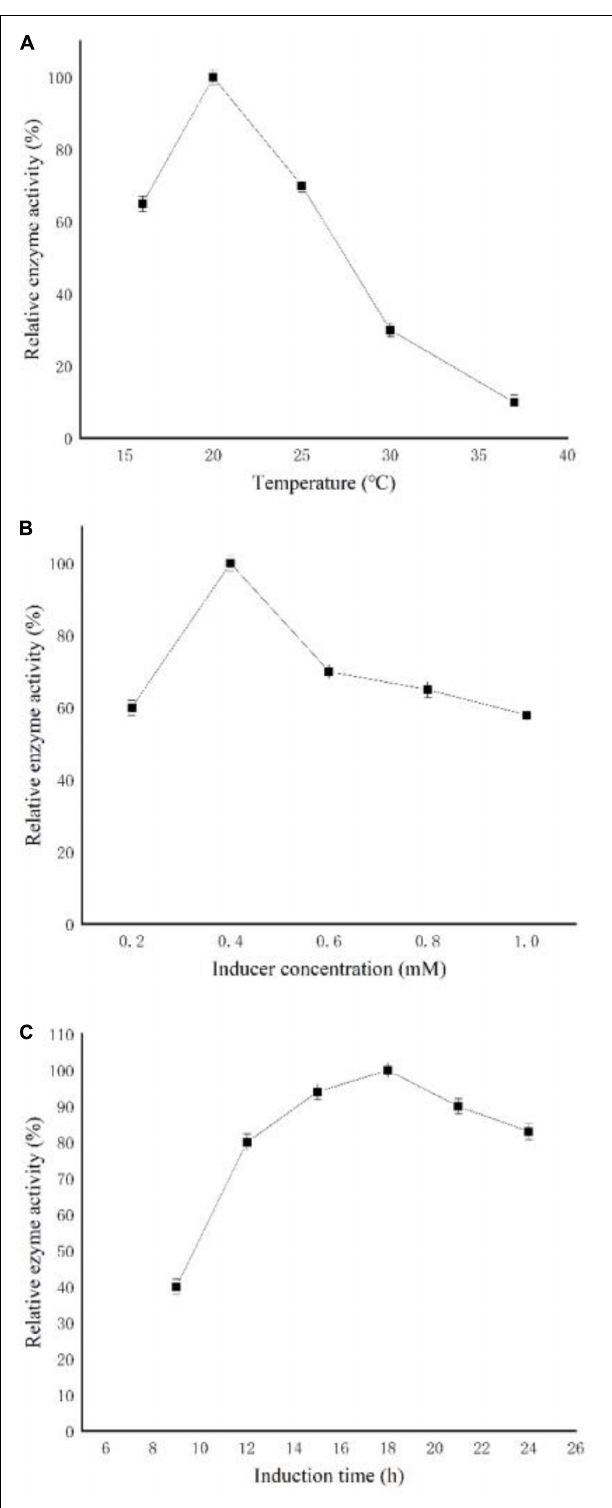
FIGURE 1 | Effects of induction conditions on the expression of recombinant cyclodextrin glycosyltransferase (CGTase). (A) Induction temperature, (B) isopropyl β - D - L -thiogalactopyranoside (IPTG) concentration, and (C) induction time.